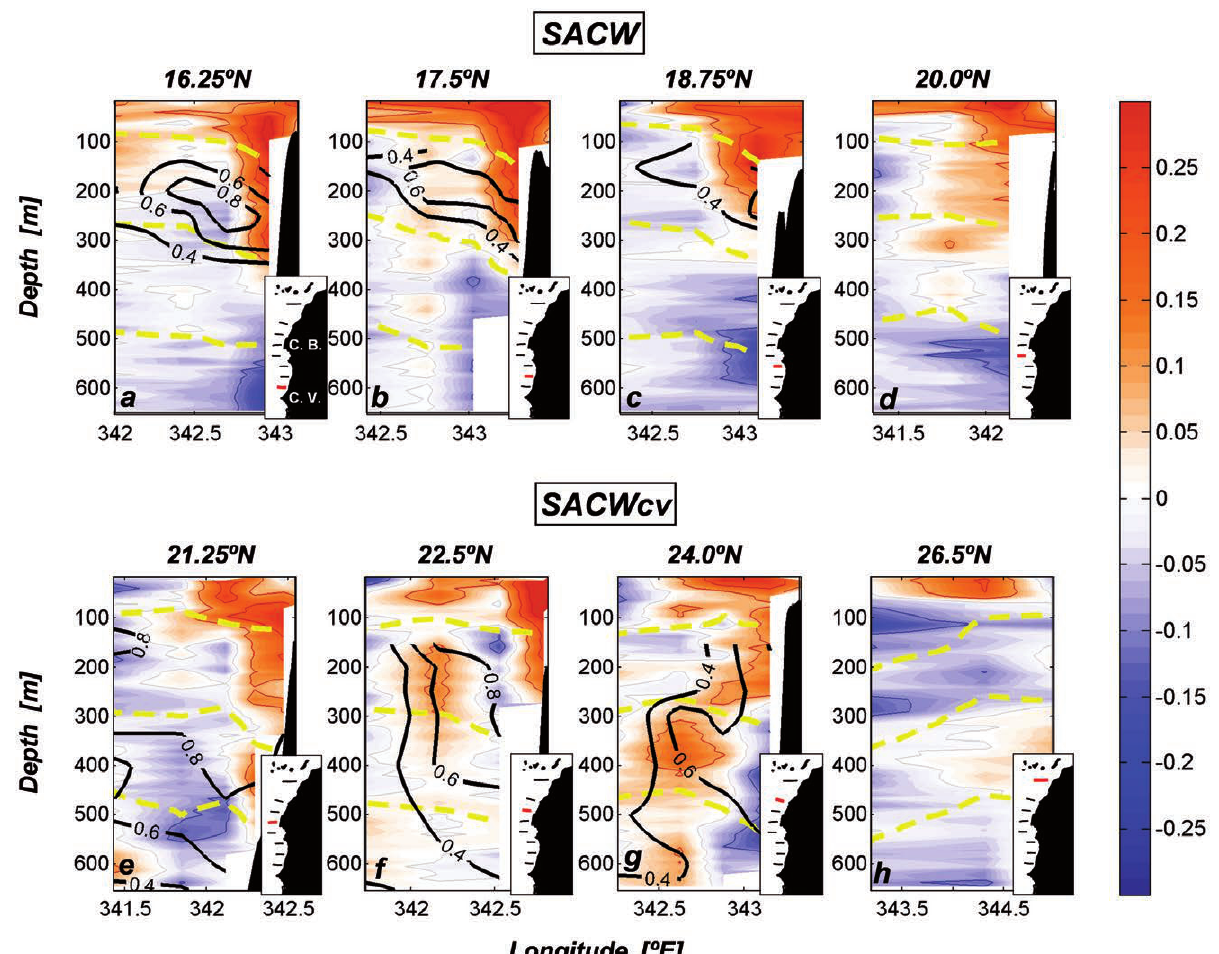
F ig . 4. – Distribution of water masses on eight different cross-shore sections (Fig. 1). The meridional velocity (in [m s –1 ]) is colour-coded ac- cording to the right-hand-side colour bar, with positive values denoting northward flow; contours are drawn every 0.1 m s –1 interval. The black lines show either the fraction of SACW south of Cape Blanc (top panels) or the fraction of SACWcv north of Cape Blanc (bottom panels); in the upper panels the remaining water-mass contribution is only SACWcv, while in the lower panels it is NACW. Three selected isopycnals (26.46, 26.85 and 27.1) are drawn in yellow. The map insets indicate the location of the corresponding